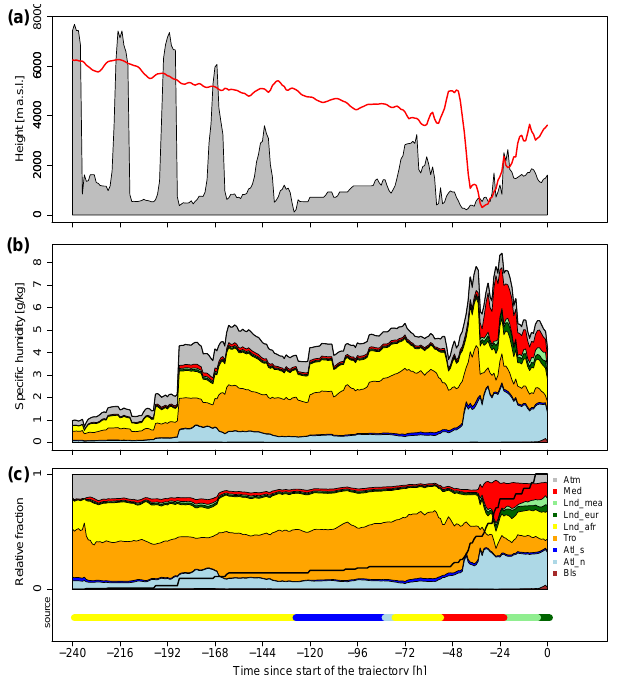
Figure 13. Same as Fig. 12, but for a trajectory moving from Africa towards eastern Europe (trajectory B in Fig. 11).